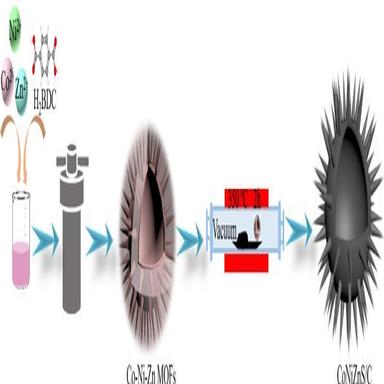
Schematic illustration for the fabrication process of CoNiZnS/C composite.